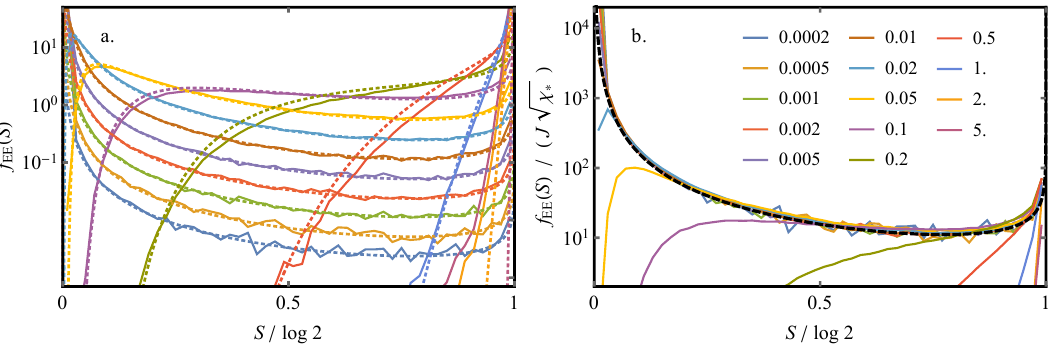
Figure 6: Distribution of entanglement entropies : The distribution of spin entangle- ment entropies in the L = 12 Spin-ETH model is numerically extracted for coupling (cid:112) χ ( 0, h ) inset in right panel). a) data for each coupling strengths (values of J (cid:63) S strength is plotted (solid colours) together with the predicted analytic form (78) (dashed line). b) data from the left panel is collapsed in accordance with (80), and plotted with the theoretical curve (black dashed line). N = 800 realisations per data